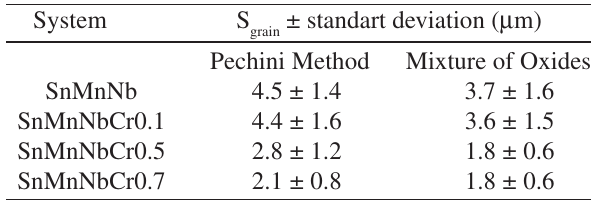
Table 4. Mean grain size (S 1300 °C for 3 h.